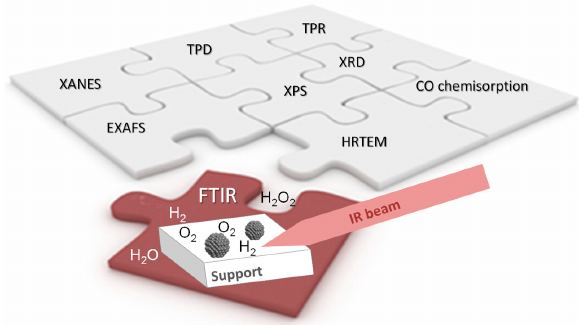
Figure 25. Role of the FTIR spectroscopy in catalyst characterisation. 1032